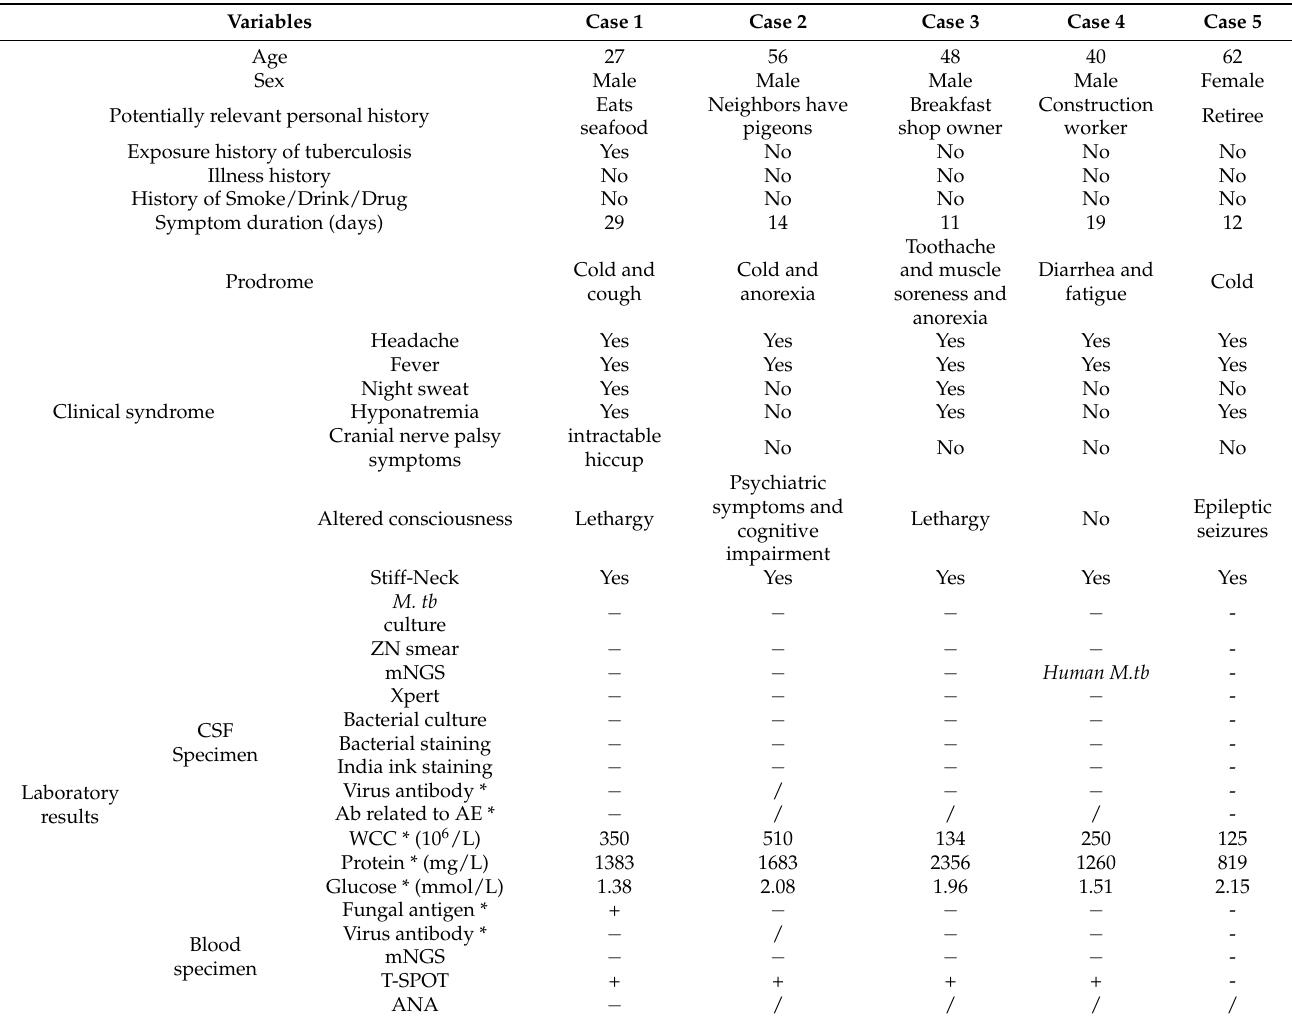
Table 1. The detailed clinical information and laboratory test results of the five TBM patients.